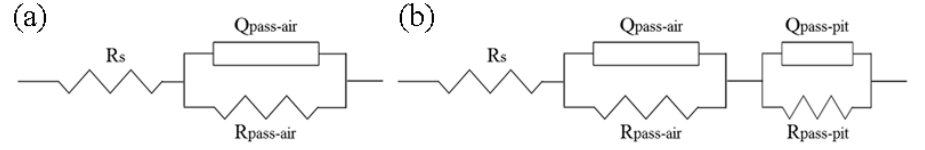
Figure 5. Randle equivalent circuits of S32750 after exposure at different times in the simulated marine atmosphere: ( a ) without pitting and ( b ) with pitting.